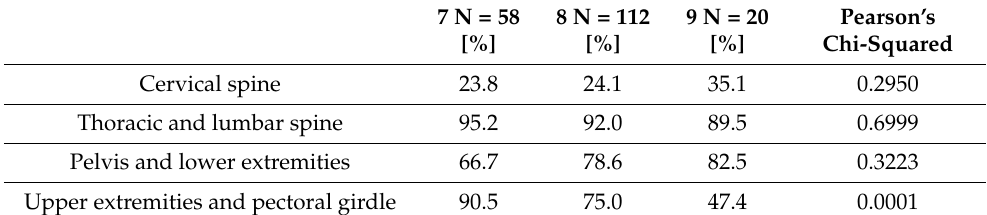
Table 3. Incidence of body posture abnormalities in individual age